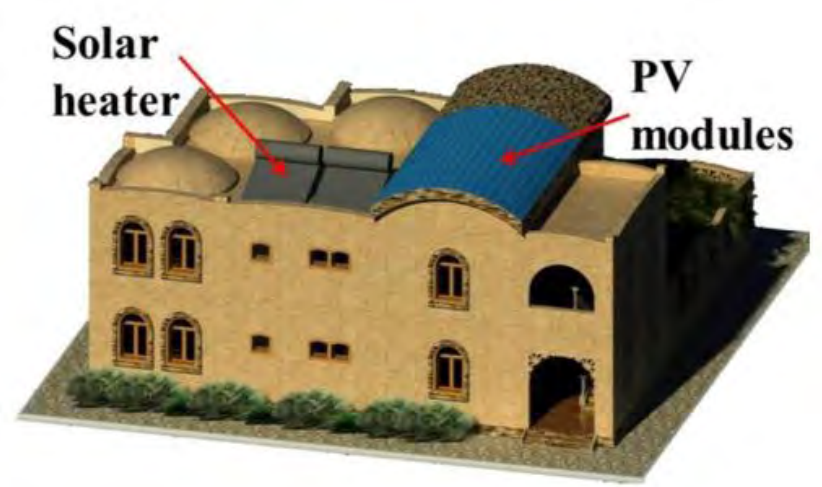
Figure 5. Renewable energy resources in the two story prototype house